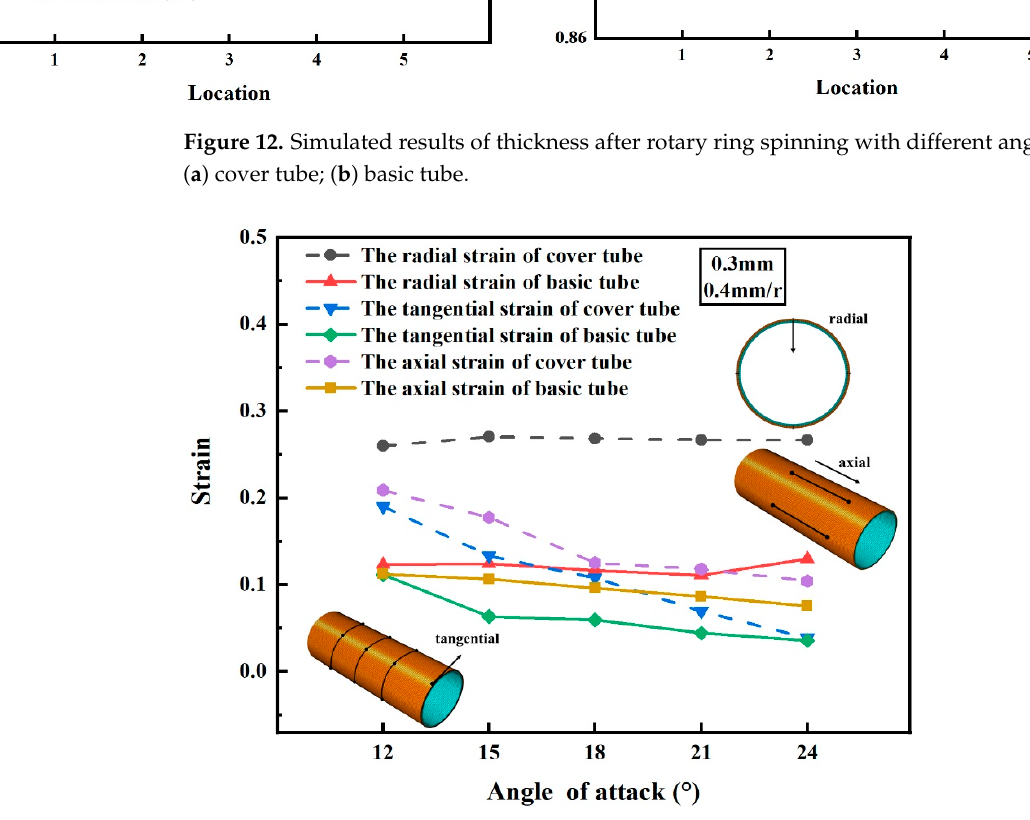
Figure 13. Three-way strain distribution for basic and cover tubes at di ff erent angles of a tt acks of rotary ring. rotary